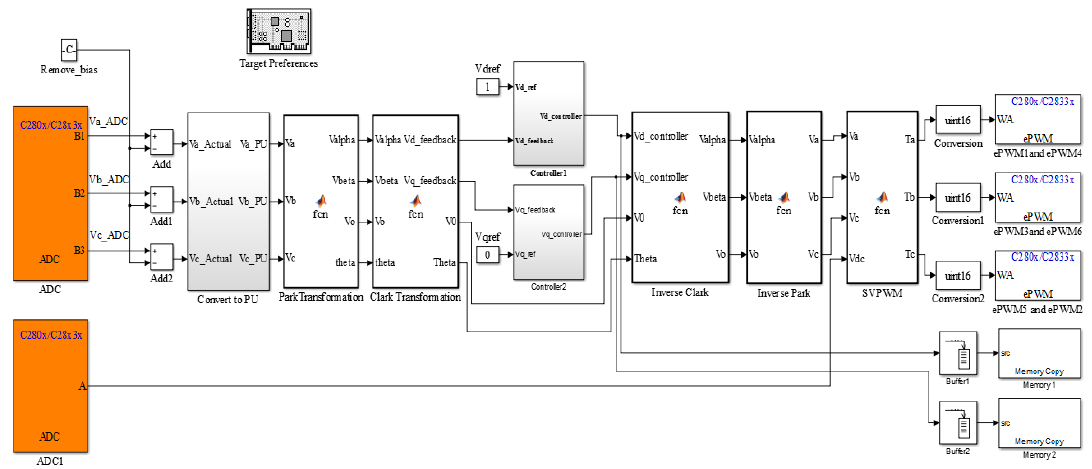
Figure 9. Real ‐ time implementation of the eZdsp F28335 inverter system algorithm. Figure 9. Real-time implementation of the eZdsp F28335 inverter system